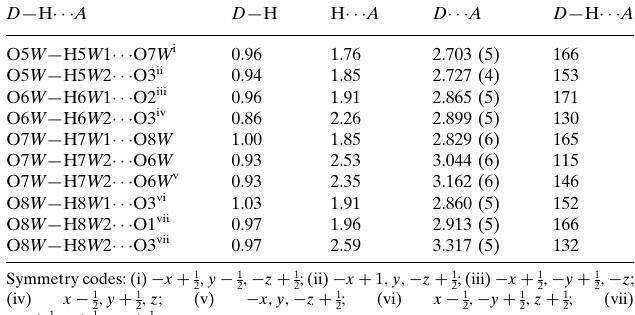
Hydrogen-bond geometry (A˚ , (cid:2) ). D —H (cid:1)(cid:1)(cid:1)